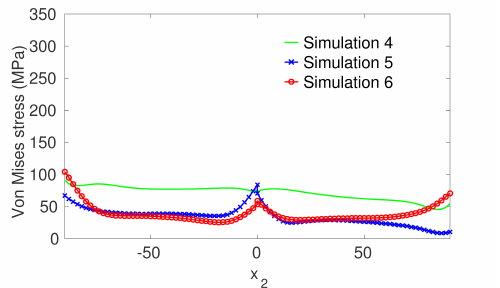
Figure 11. Profiles of Von Mises stress along x 2 through point C (40,0,0) obtained by FE simulations 4, 5 and